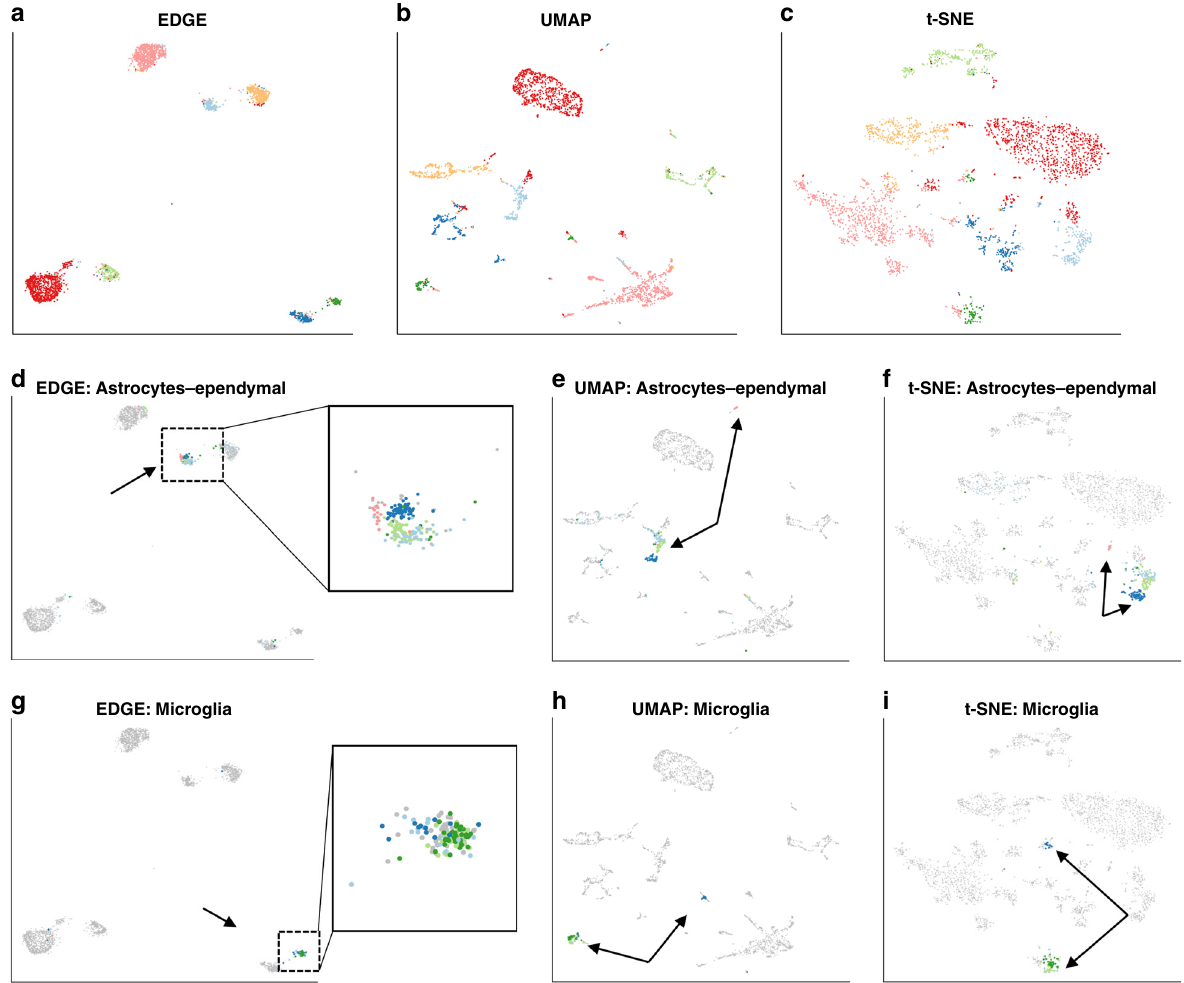
Fig. 4 Local and global structure can be preserved by EDGE in the mouse brain dataset. a – c The two-dimensional representations learnt by EDGE, UMAP, and t-SNE, respectively. d – f Same as a – c , but only the astrocytes-ependymal cells are highlighted with their subtypes. g – i Same as a – c , but only the microglia cells are highlighted with their subtypes.